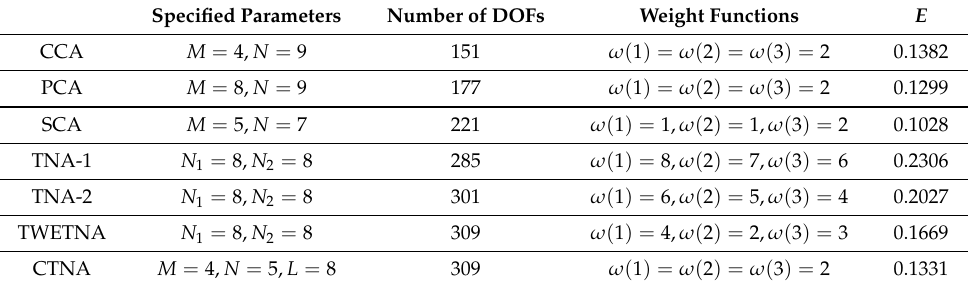
Table 4. Character comparison for sparse arrays with R = 16 sensors.